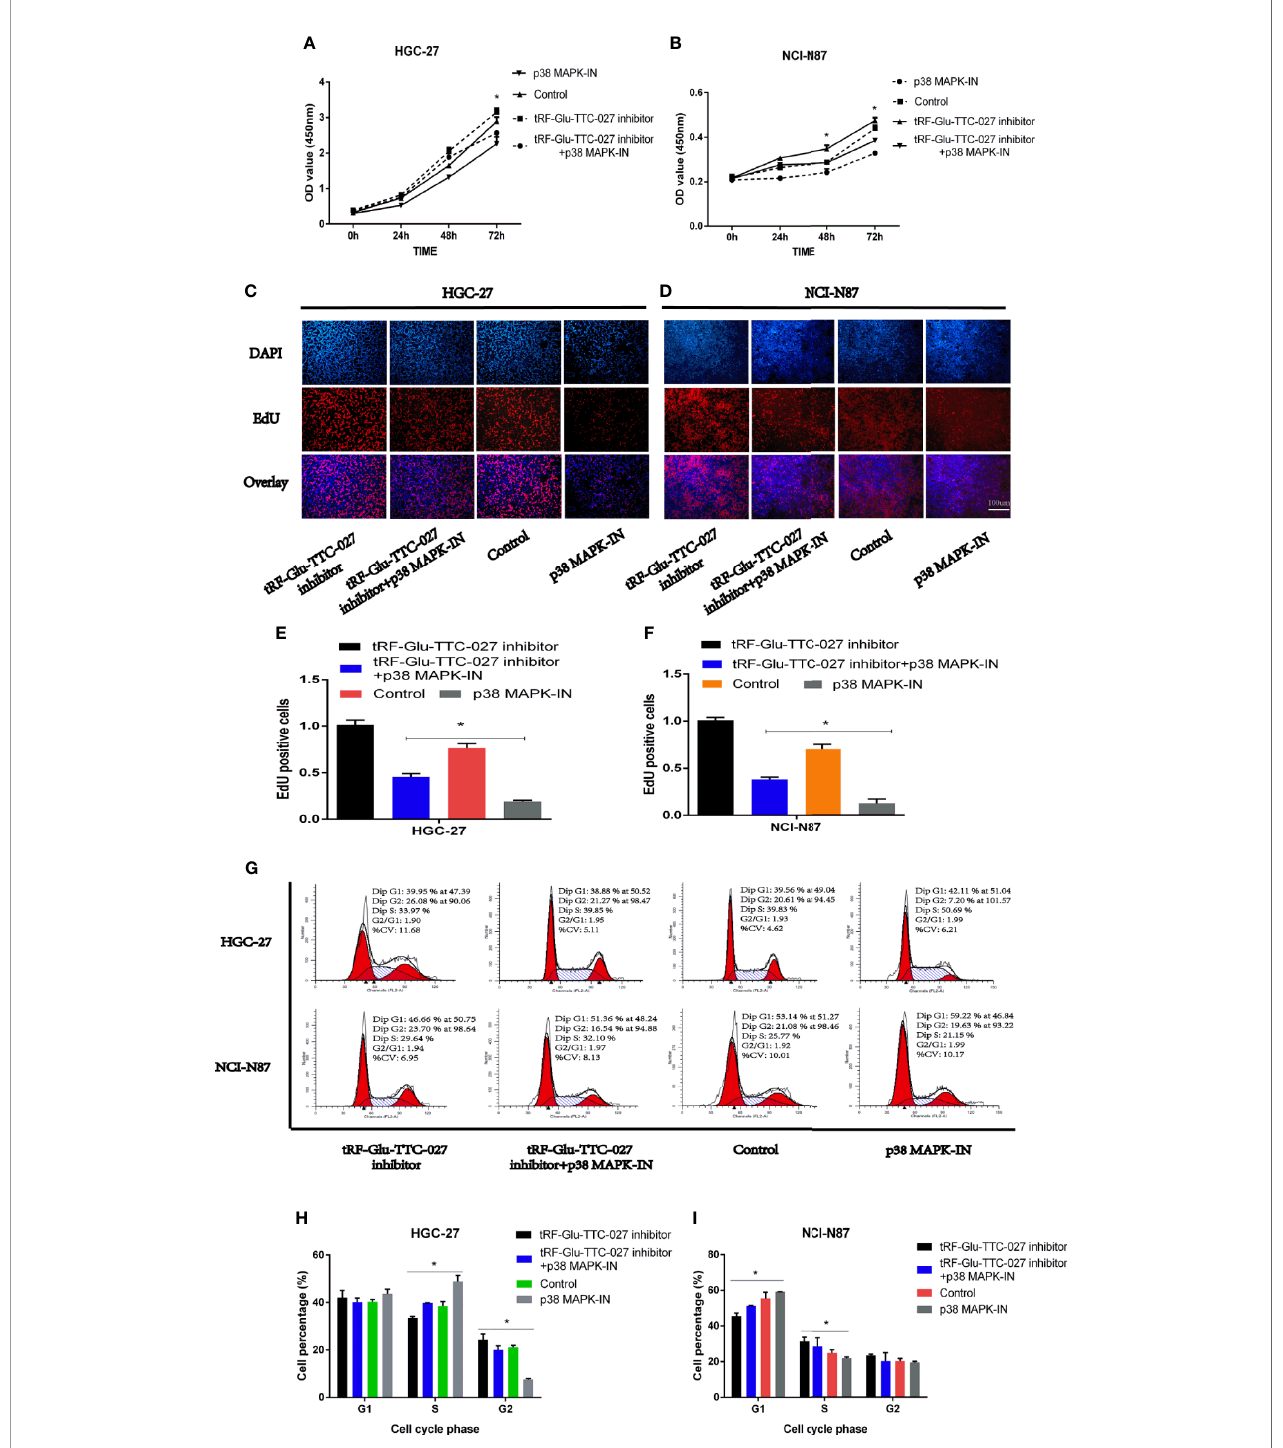
FIGURE 5 | The rescue assays were performed to evaluate the regulative relationship between tRF-Glu-TTC-027 and p38 MAPK pathway inhibitor (p38 MAPK-IN) in HGC-27 and NCI-N87. (A, B) tRF-Glu-TTC-027 inhibitor facilitated the proliferation of HGC-27 and NCI-N87, and the inhibitory effect of p38 MAPK-IN could be reversed by tRF-Glu-TTC-027 inhibitor. (C – F) EdU assay demonstrated that tRF-Glu-TTC-027 inhibitor promoted the DNA replication in GC cell lines, while p38 MAPK-IN signi fi cantly suppressed the EdU assimilation and could be reversed by tRF-Glu-TTC-027 inhibitor during the proliferative process. (G – I) p38 MAPK-IN imposed the inhibitory effect on the GC cells to cause the cell cycle arrest and this was able to be relieved by tRF-Glu-TTC-027 inhibitor. (*P < 0.05, Student ’ s t-test. Scale bar = 100 µm).